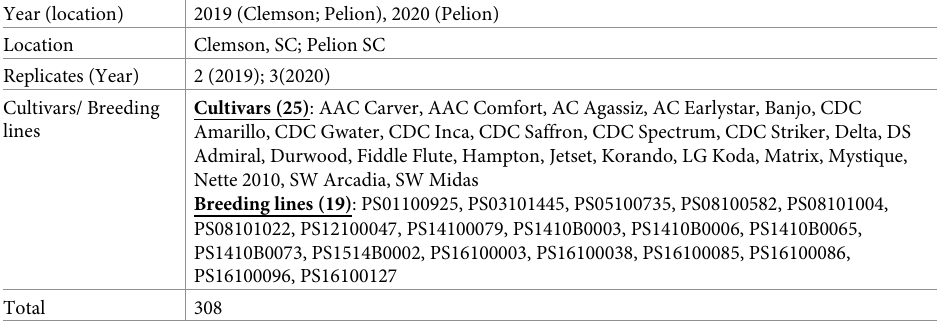
Table 1. Experimental design used in the dry pea nutritional breeding